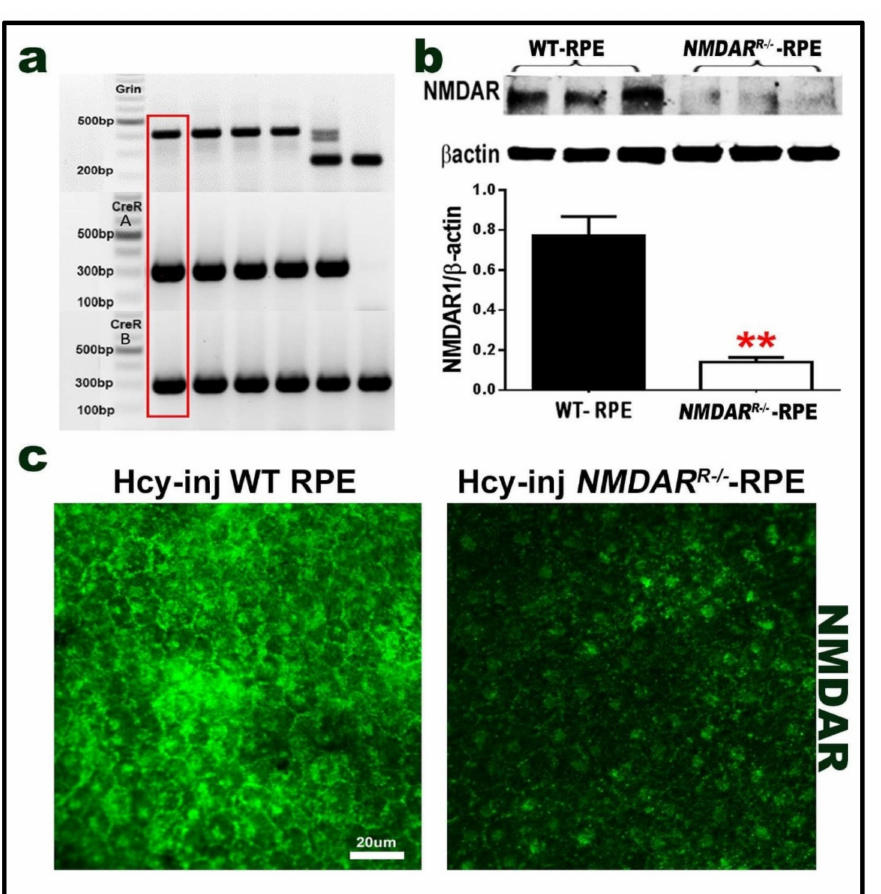
Figure 4. Mouse with the genetic deletion of NMDAR ( NMDAR R − / − ). A mouse deficient in NMDAR in the retinal epithelial cells ( NMDAR R − / − ) was generated in our lab by the backcrossing of B6.129S4-Grin1tm2Stl/J: (otherwise known as NR1flox, fNR1) with a CreR mouse. ( a ) PCR, genotyping analysis. Grin genotyping results: ( Grin +/+ ) has only one band ~400 bp. ( Grin +/ − ) has two bands ~400 bp and 232 bp. ( Grin − / − ) wild-type has a band at ~232 bp. CreR genotyping results: CreR reactionA + has band at 300bp and CreR reaction B + has band at 300 bp. The red-labeled ( NMDAr − / − R ) = Grin +/+ CreR reaction A + /CreR reaction B + . ( b ) Western blot analysis to confirm the reduced expression of NMDAR in primary RPE cells isolated from wild-type mice retina and primary RPE cells isolated from NMDAR R − / − , which showed a marked reduction in comparison to normal WT mice. β -actin was used as a loading control. ( c ) Immunofluorescence expression of NMDAR (green) of RPE flat-mounts from control wild-type and NMDAR R − / − mice after the intravitreal injection of Hcy, which showed a marked reduction of NMDAR expression in the RPE layer of the mouse retina of the NMDAR R − / − mice as compared to control. ( n = 6 mice per group) Calibration bar: 20 µ m. ** p <